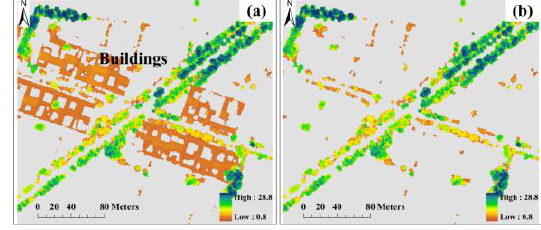
Figure 3. CHM extracted by only the morphological crown control method (a) and CHM extracted by integrating the morphological crown control method and CASI image (b).